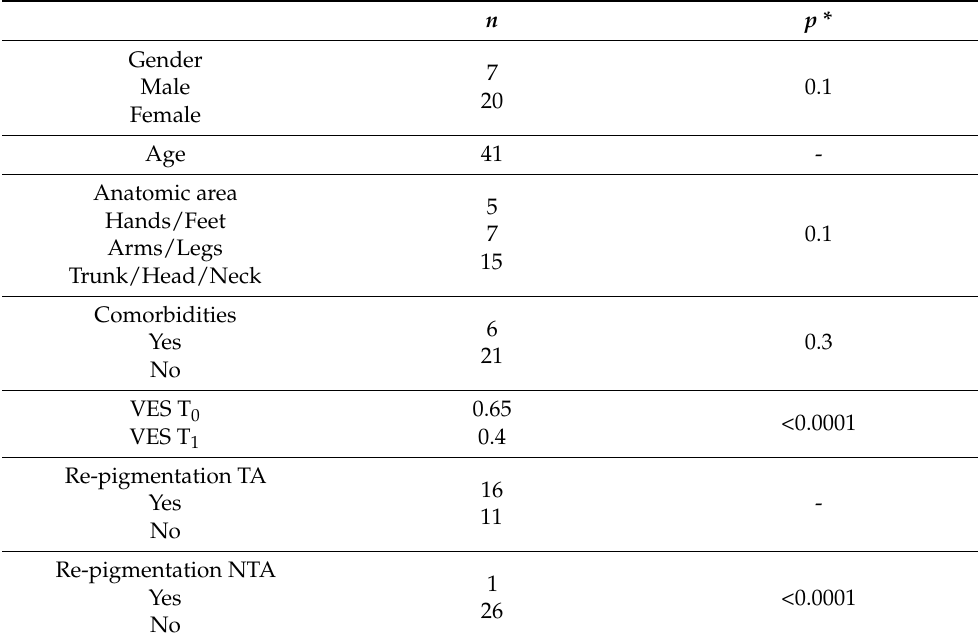
Table 1. Clinical